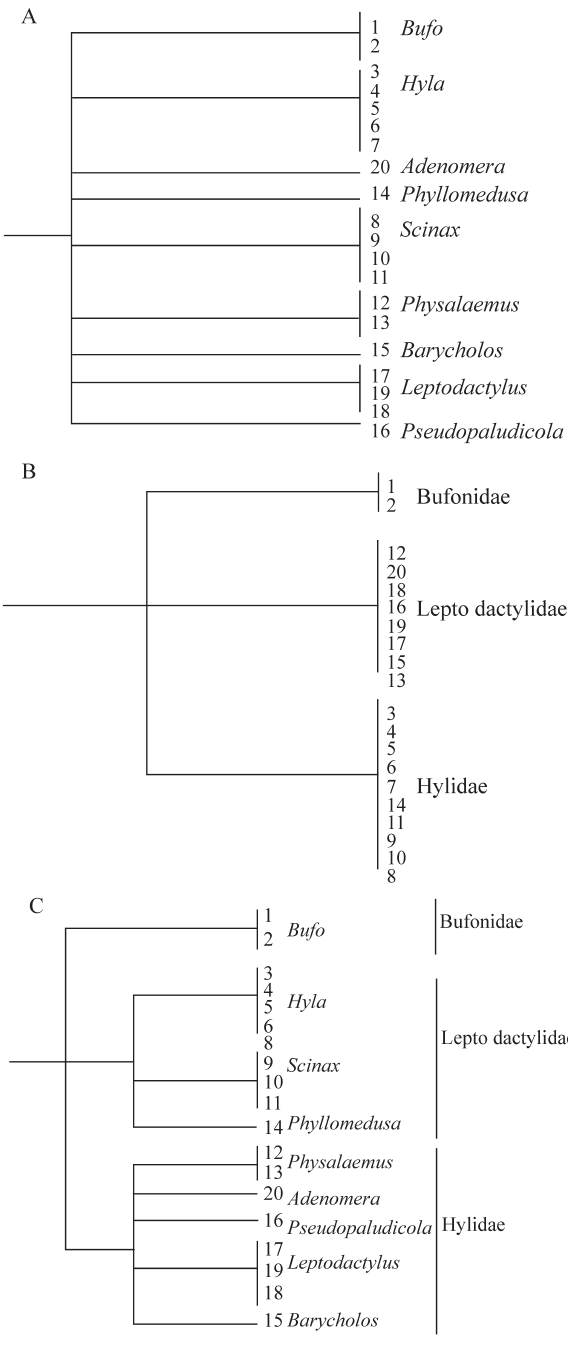
Figure 1 - Relationship among 20 species of anurans from the cerrado re- gion under the three models of taxonomic relationship, linking species within the same genera (A), species within the same family (B) and com- biningthetwohierarchicallevels(C).Thesematriceswerecomparedwith the divergence matrix using the Jaccard coefficient end the Mantel test with 5000 random